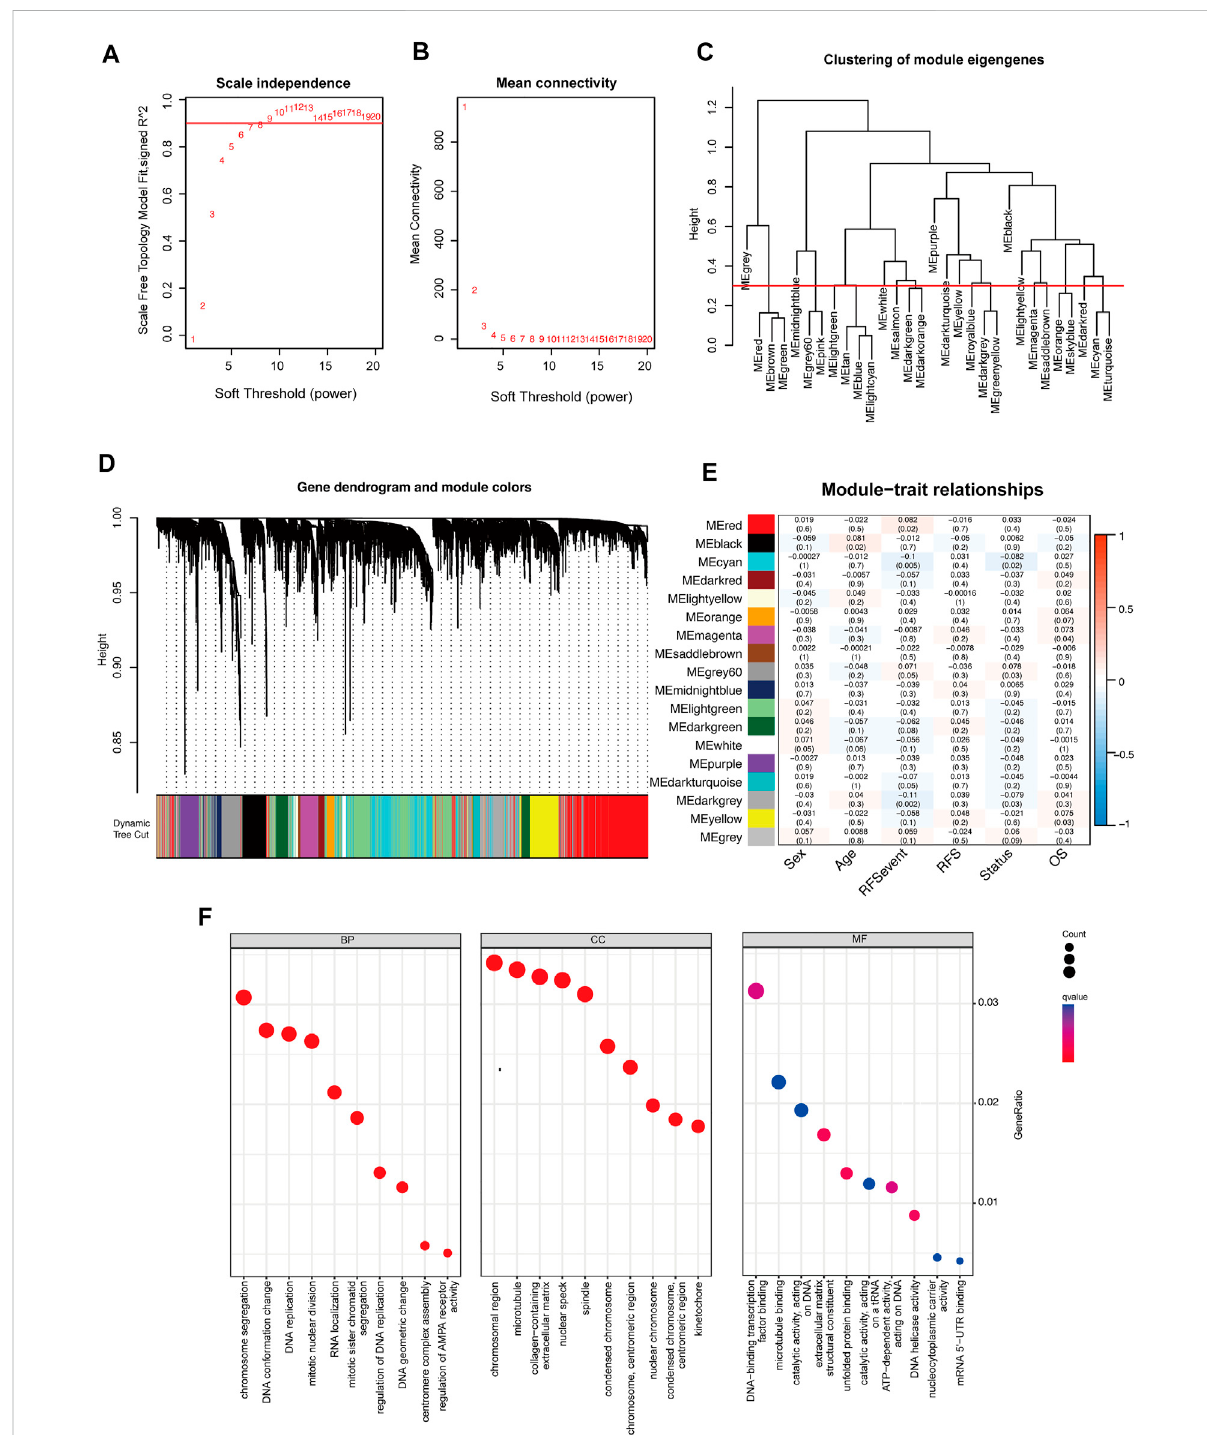
FIGURE 5 Weighted gene correlation network analysis of m 6 A methylation regulators. (A,B) Analysis of network topology to determine soft-thresholding power. (C) Eigengenedendrogramidenti fi edgroupsofcorrelatedmodules. (D) Genedendrogram wasobtained byclustering thedissimilarity based on consensus topological overlap with the corresponding module colors indicated by the color row. Each colored row represents a color-coded module that contains a group of highly connected genes. (E) Heatmap of the correlation between the module eigengenes and clinical traits of colorectal cancer. We selected the module red, cyan, gray60, dark turquoise, and dark gray blocks for subsequent analysis. (F) Gene Ontology analysis of genes in module red, cyan, gray60, dark turquoise, and dark